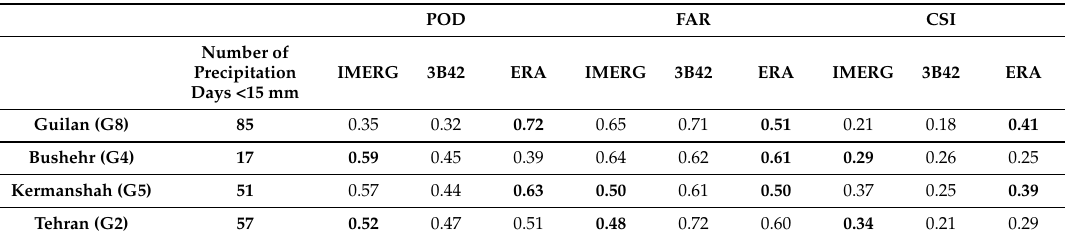
Table 17. Spatially averaged POD, FAR and CSI metrics for precipitation below 15 mm/day.